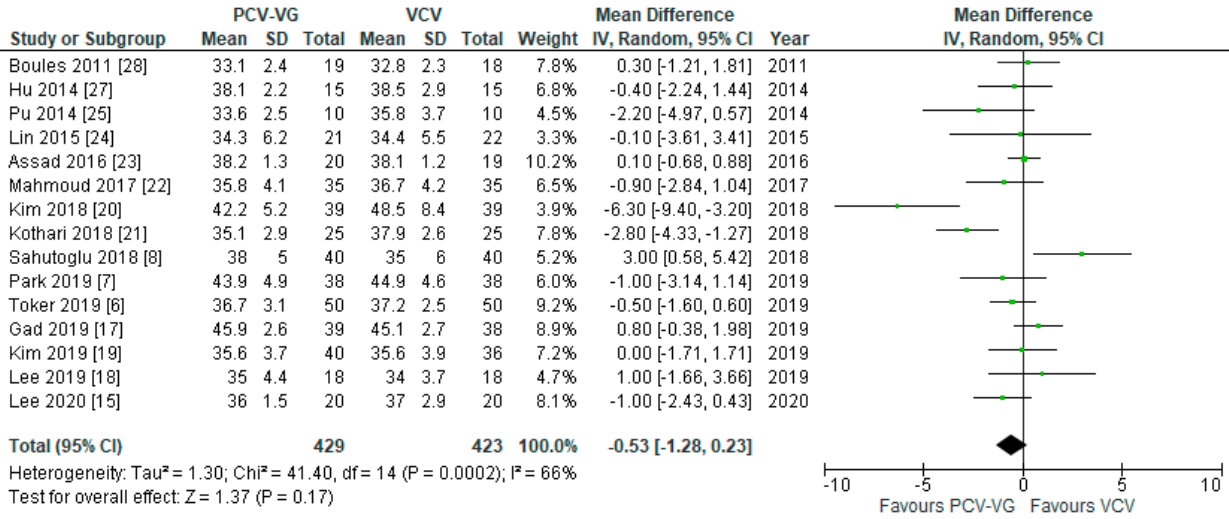
Figure 8. Arterial oxygen pressure (P a O 2 ): supine, two-lung ventilation. The green center of each square represents the weighted mean difference for individual trials, and the corresponding horizontal line stands for a 95% confidence interval. The diamonds represent pooled results.